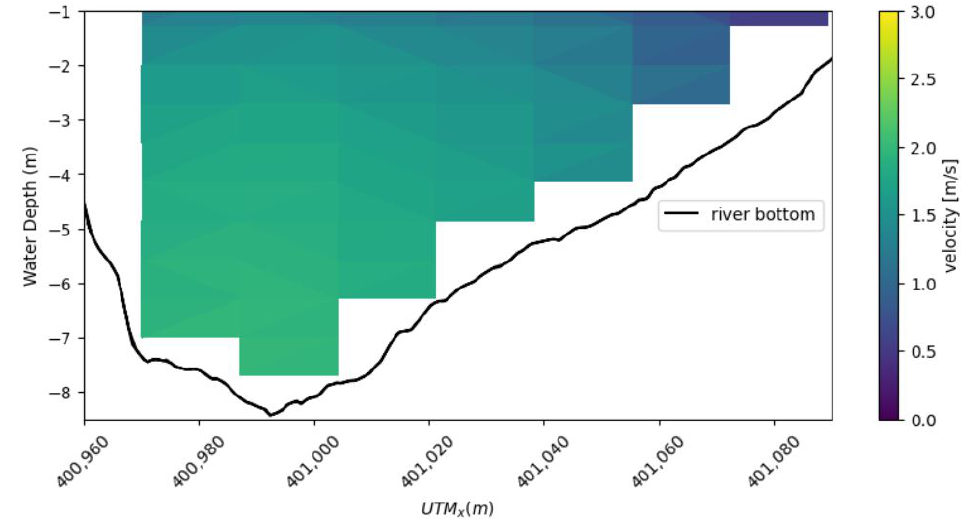
Figure 7. Delft3D modeled velocity magnitude at the same ideal transect shown in Figure